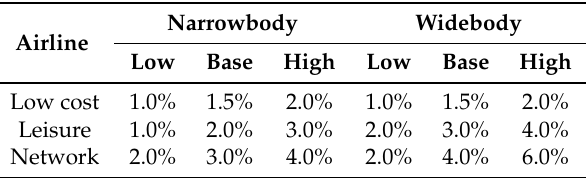
Table 1. Assumed number of delayed transfer passengers depending on business model and scenario based on total numbers of transfer passengers provided by Frankfurt Airport [48].